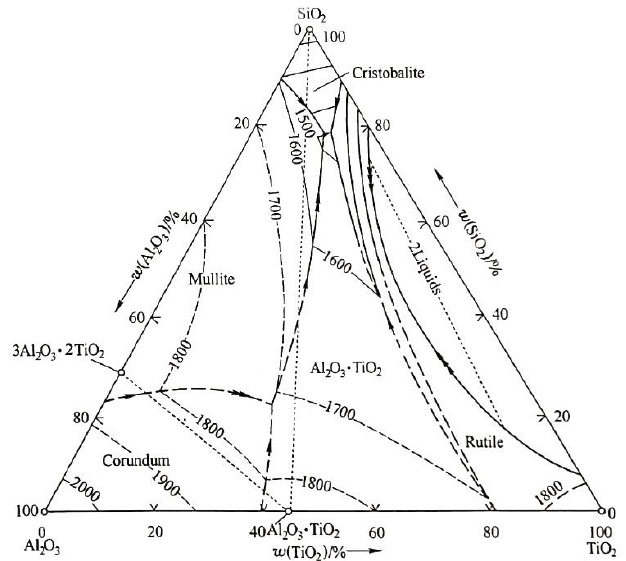
Figure 8. Phase diagram in the Al 2 O 3 -TiO 2 -SiO 2 ternary system [24].